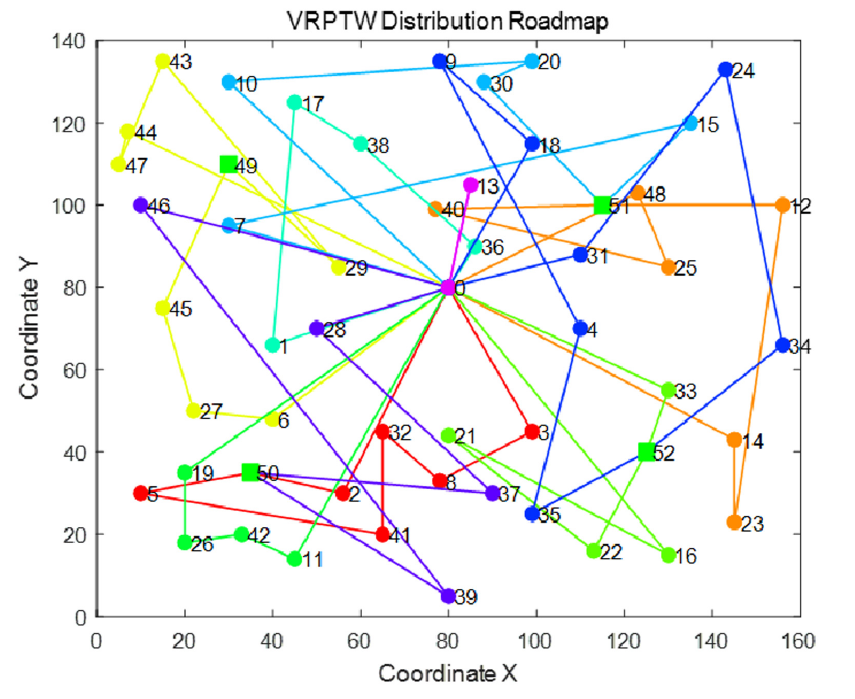
Fig 7. NSGA-II optimal path.